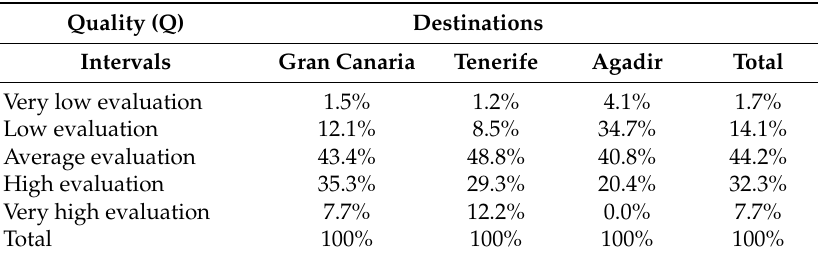
Table 7. Comparative analysis of the quality (Q) variable.